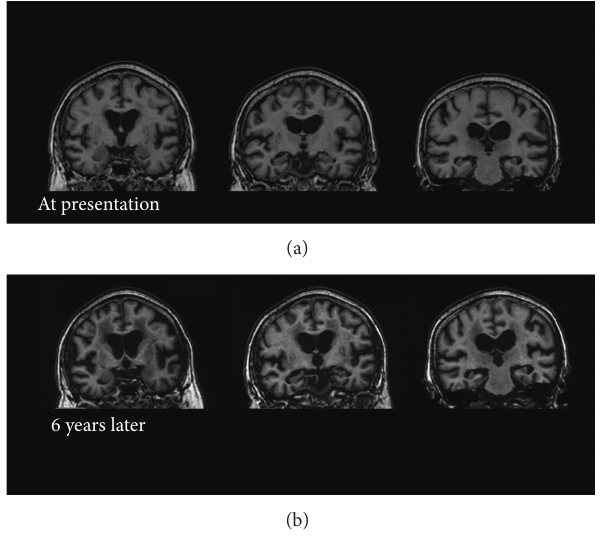
Figure 5: Horizontal T2 weighted brain Magnetic Resonance Image (MRI) of the patient in Case B at presentation (a) and 6 years later (b). Leukoaraiosis at presentation and its progression across 6 years were clearly observed as high signal intensity in the periventricular white matter.